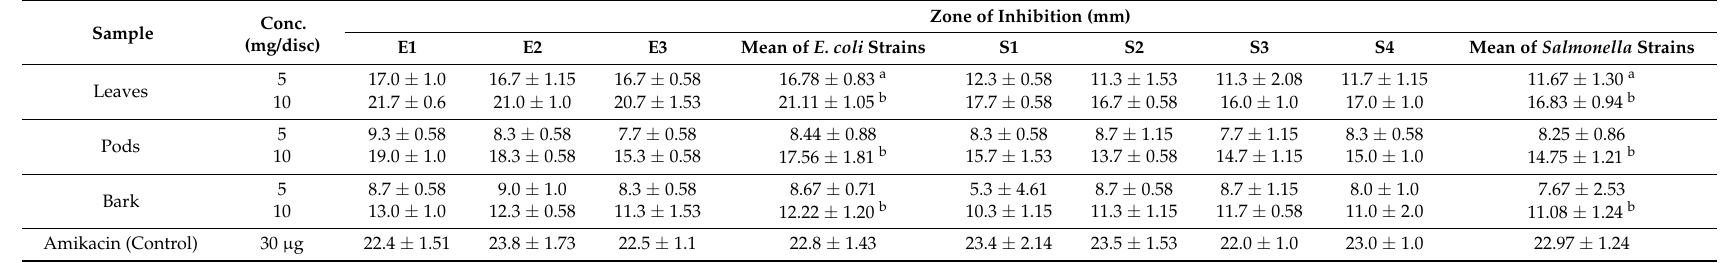
Table 2. Antibacterial effects of Acacia nilotica extracts against clinical and food isolates of E. coli and Salmonella .